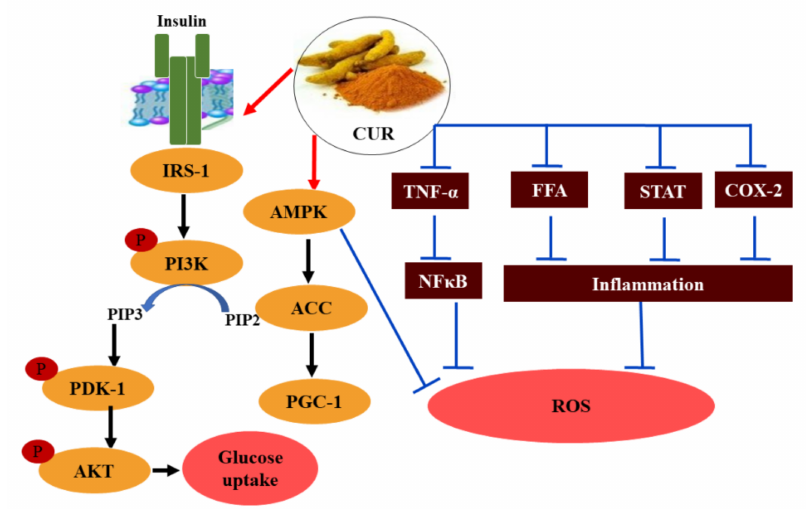
Figure 7. Mechanisms of the potential antidiabetic effect of CUR. IRS-1: insulin receptor substrate-1, PI3K: phosphatidyl inositol-3-kinase, PIP2: phosphatidylinositol 4,5-bisphosphate, PIP3: phos- phatidylinositol 3,4,5-trisphosphate, PDKI: phosphoinositide-dependent protein kinase 1, Akt: pro- tein kinase B, AMPK: adenosine monophosphate-activated protein kinase, ACC: acetyl CoA car- boxylase, PGC-1: peroxisome proliferator-activated receptor-gamma coactivator, TNF- α : tumor necrosis factor-alpha, NF- κ B: nuclear factor-kappa B, FFA: free fatty acids, STAT: Signal transducer and activator of transcription, COX-2: cyclooxygenase-2, ROS: reactive oxygen